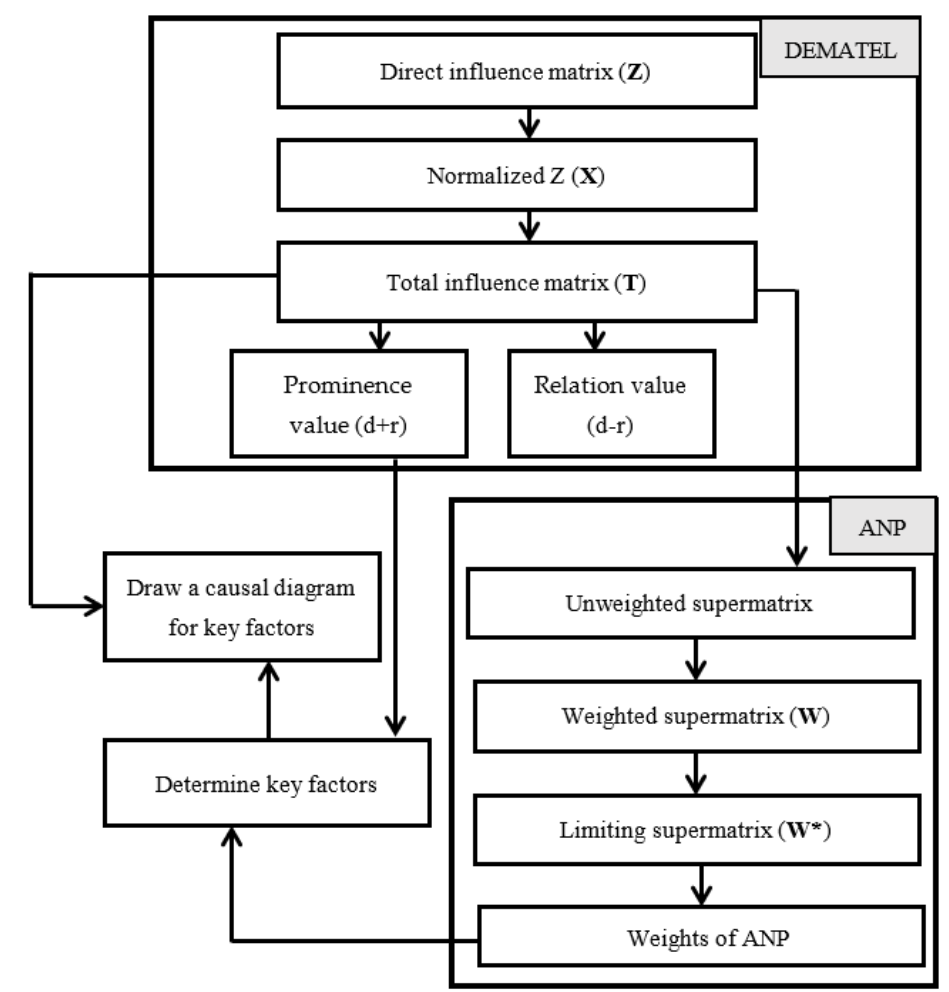
Figure 2. The DANP framework of this study. Table 2. The details of column ( d ), row ( r ), d + r , d − r , and